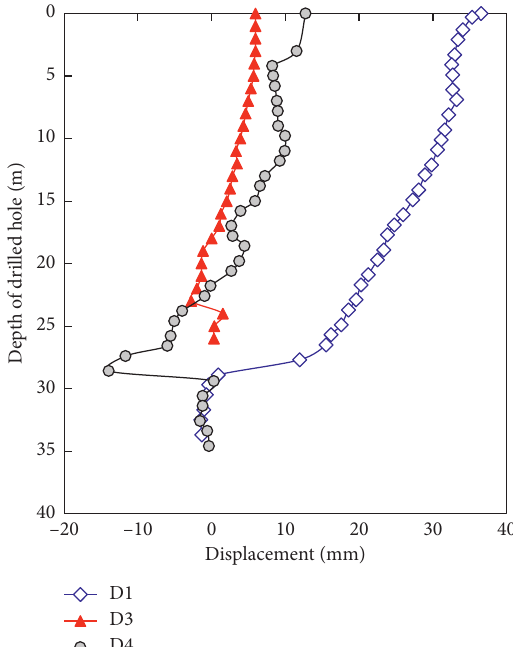
Figure 16: Internal deformation of